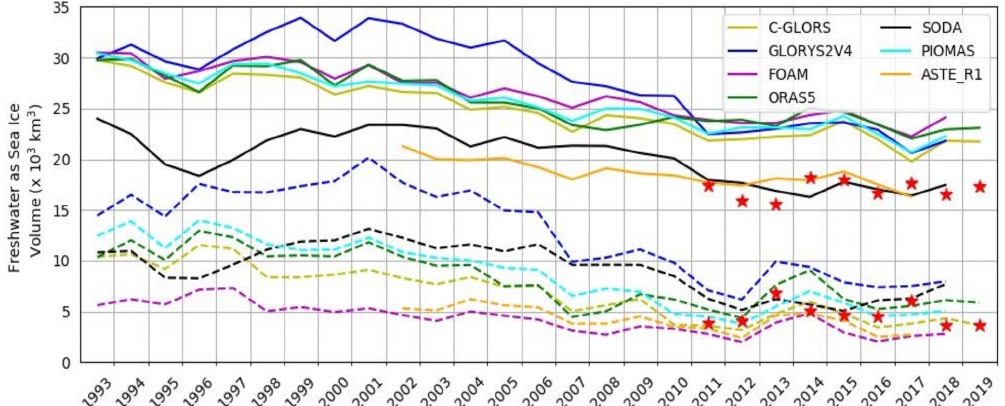
Figure 5. Time series of annual freshwater volume stored as sea ice from seven ORAs and CryoSat-2 (red stars) (in 10 3 km 3 ). The sea ice volume is calculated as the product of sea ice area and thickness. Annual volume maxima are shown by bold lines, while annual minima are shown by dashed